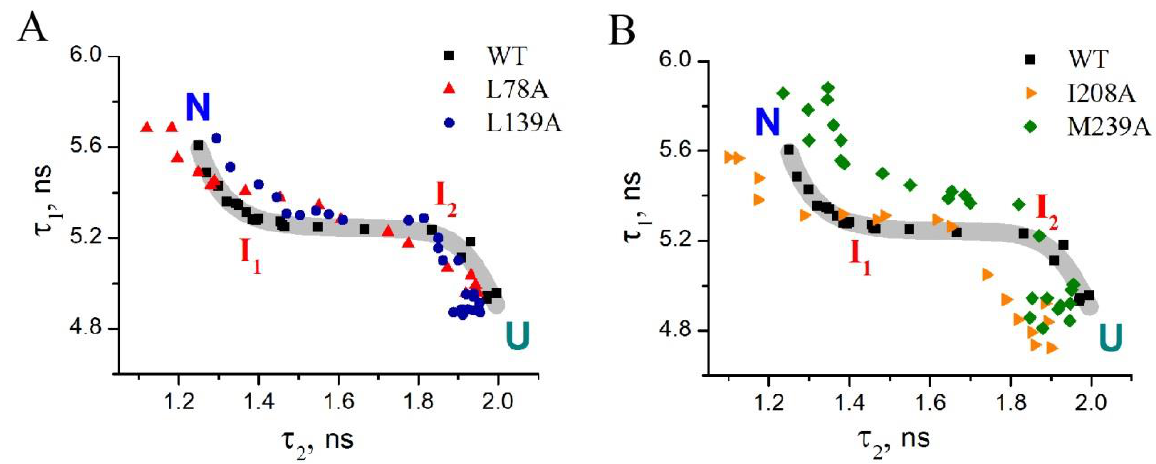
Figure 4. Mutual dependency of two fluorescence lifetimes, τ 1 and τ 2 , during urea-induced unfolding for carbonic anhydrase: wild-type (black), L78A (red), L139A (blue), I208A(orange), M239A (green). The smoothed dependency for wild-type protein is shown by a thick gray line. Bends on the curve indicate the presence of intermediate states during the protein unfolding. N, U, I 1 , I 2 indicate the areas of the parametric plot for wild-type protein that correspond to the native, unfolded, and intermediate states, respectively. On panel ( A ) — the proteins whose unfolding pathway does not differ from each other, on panel ( B ) — proteins whose unfolding pathway is different.